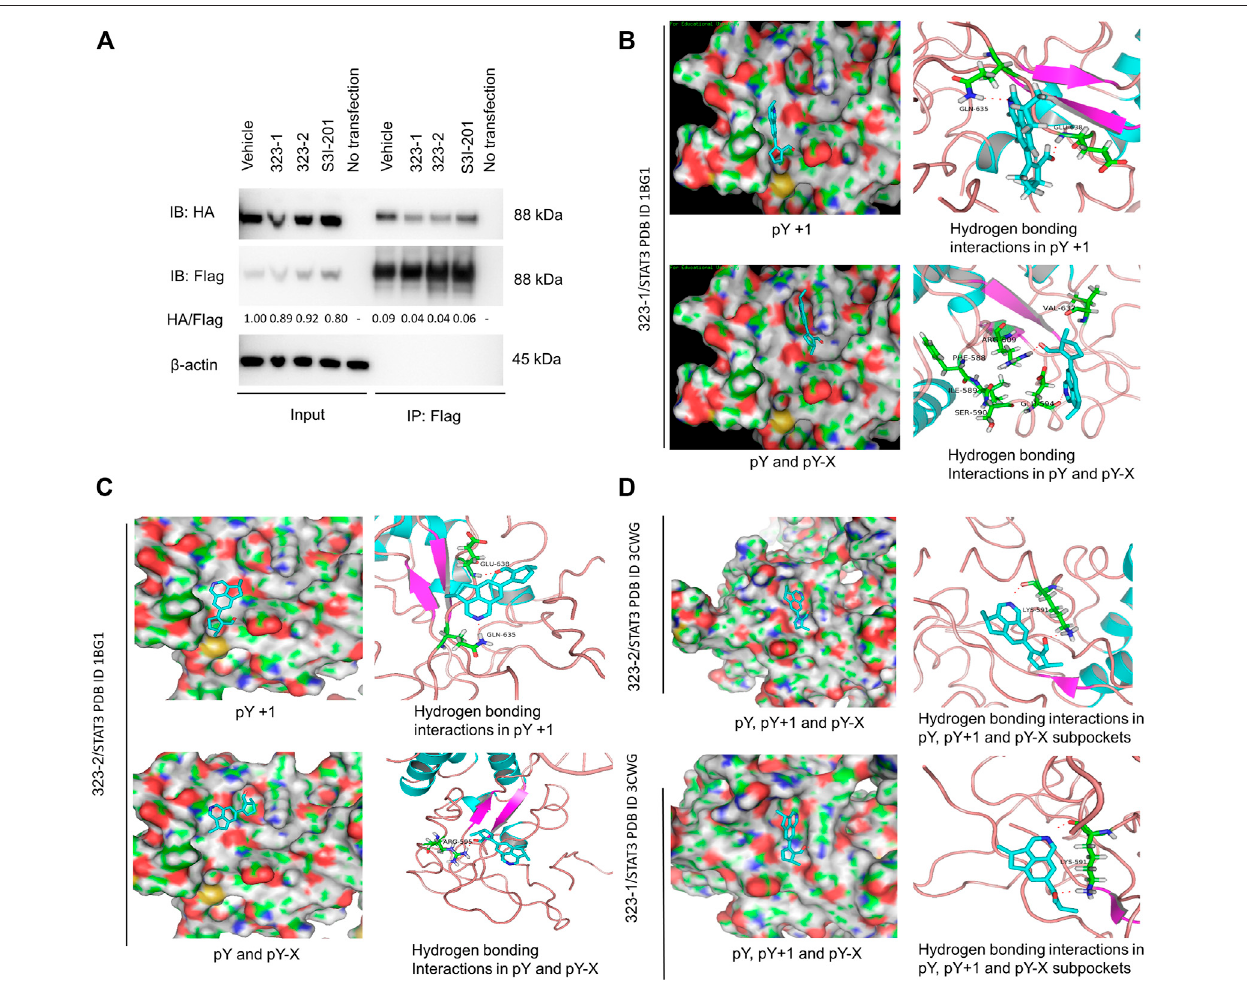
FIGURE 3 | Compounds 323 – 1 and 323 – 2 block STAT3 dimerization and target the STAT3 SH2 domain. (A) HEK 293T cells were transfected with FLAG-STAT3 andHA-STAT3andweretreatedwithvehicle(DMSO),50 µM323 – 1,50 µM323 – 2,and200 µMS3I-201for24 h.Extractswereimmunoprecipitatedwiththeanti-FLAG antibody, followed byimmunoblotting with anti-HA, anti-FLAG, and anti- β -actin (ab8226). The HA/FLAG ratio wascalculated byImageJ software, and the vehicle within the input group was set as control. Data are shown as representative results of three experiments. (B, C) In silico computational docking analysis by Maestro 9.0 Glidesoftwareselected323 – 1 (B) or323 – 2 (C) asligandsand STAT3 protein (PDB:1BG1).Thekeyaminoacidresidues areusedinthepositivecontrolasthecenterof the grid. The center of the grid is less than 18 Å, docking Select XP for precision, and selected 100 output constellations. (D) Molecular docking of compounds 323 – 1 and 323 – 2 on STAT3 (PDB: 3CWG) is previously